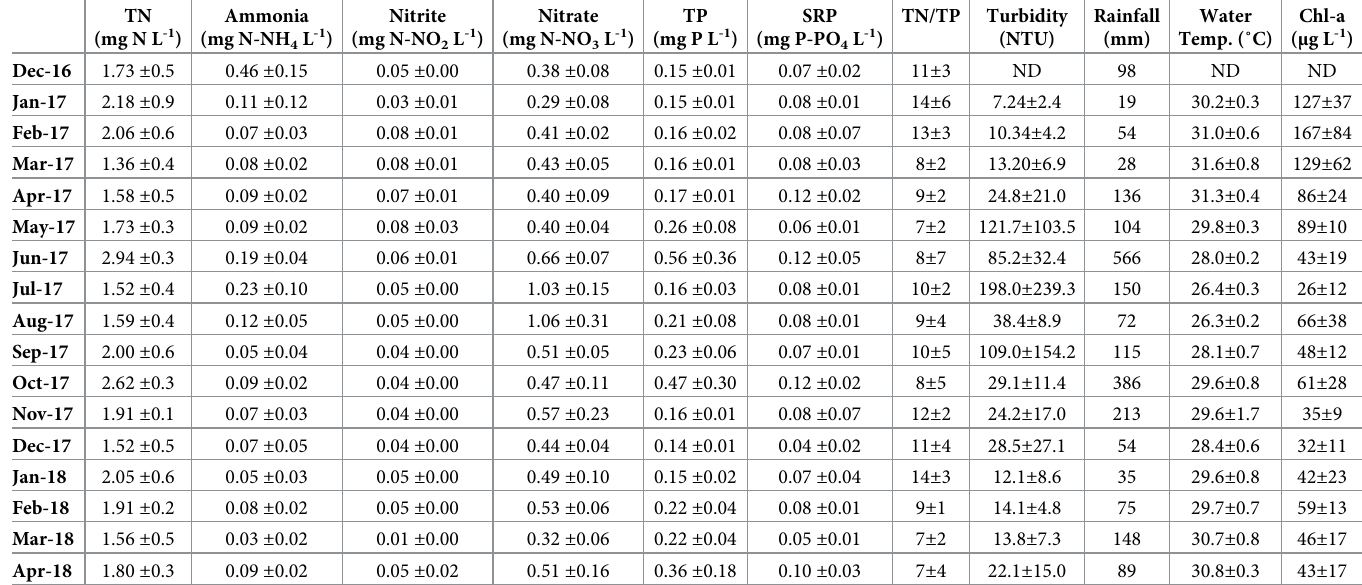
Table 1. Monthly average values ( ± standard deviations) of the chemical and physical variables measured at the six sampling stations in Lagoon Aghien. TN (mg N L -1